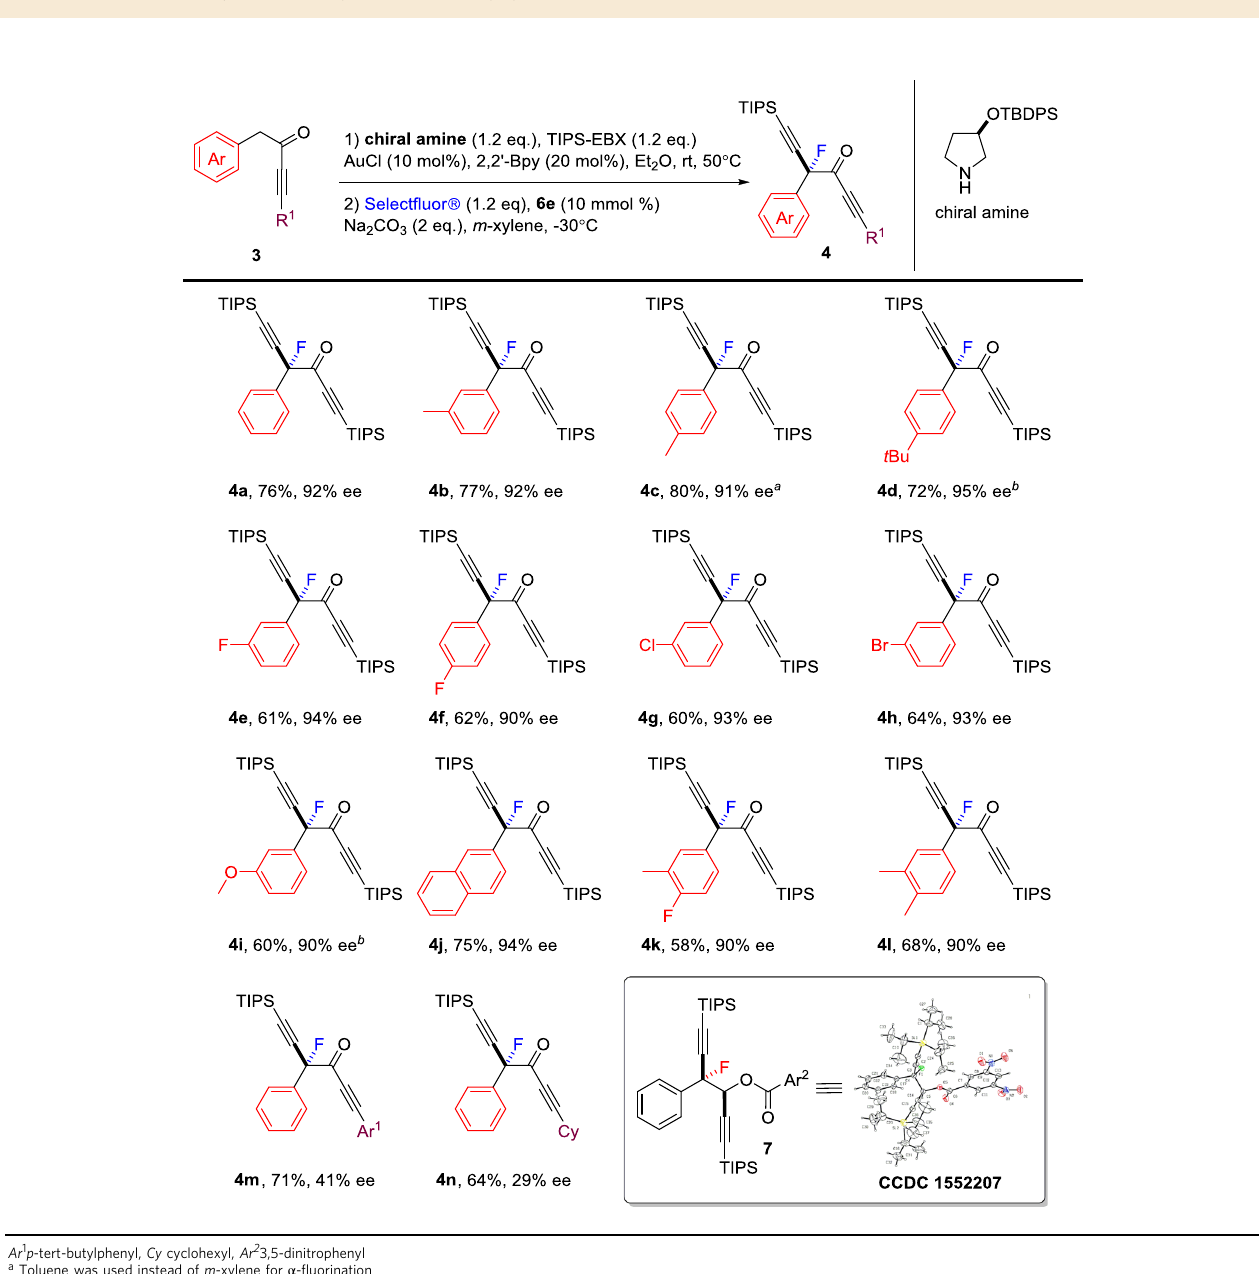
Table 4 Substrate scope of the asymmetric α -alkynylation – α - fl